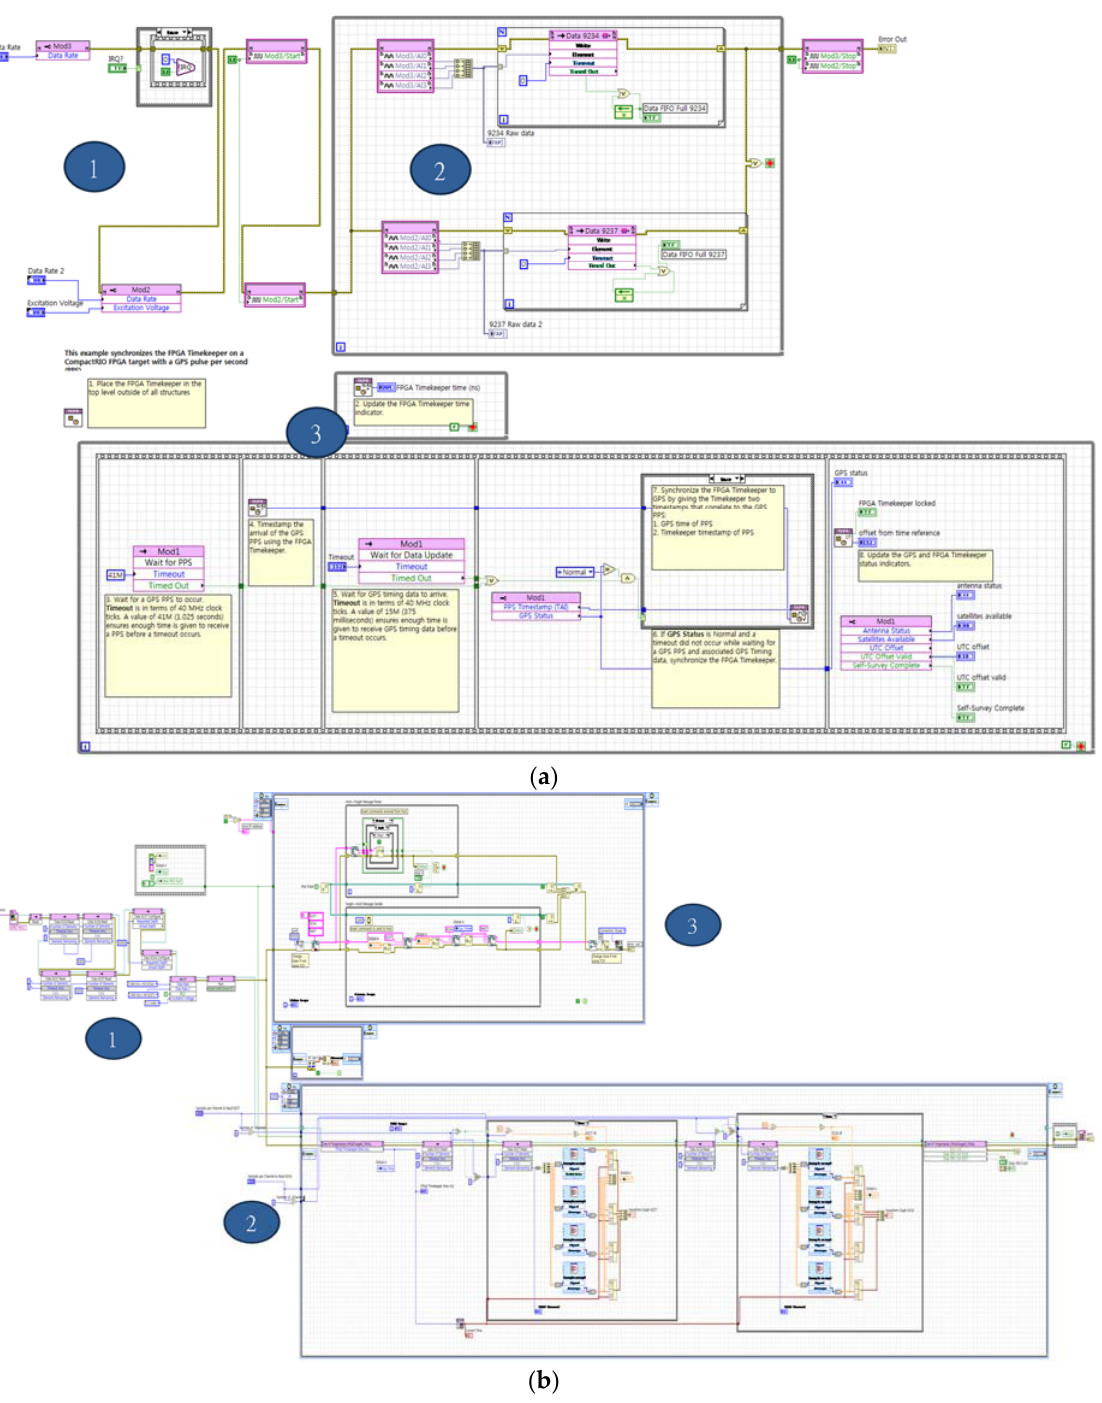
Figure 3. Target S/W for wireless unified ‐ maintenance system (WUMS): ( a ) field ‐ programmable gate array (FPGA); ( b ) real ‐ time operating system (RTOS).